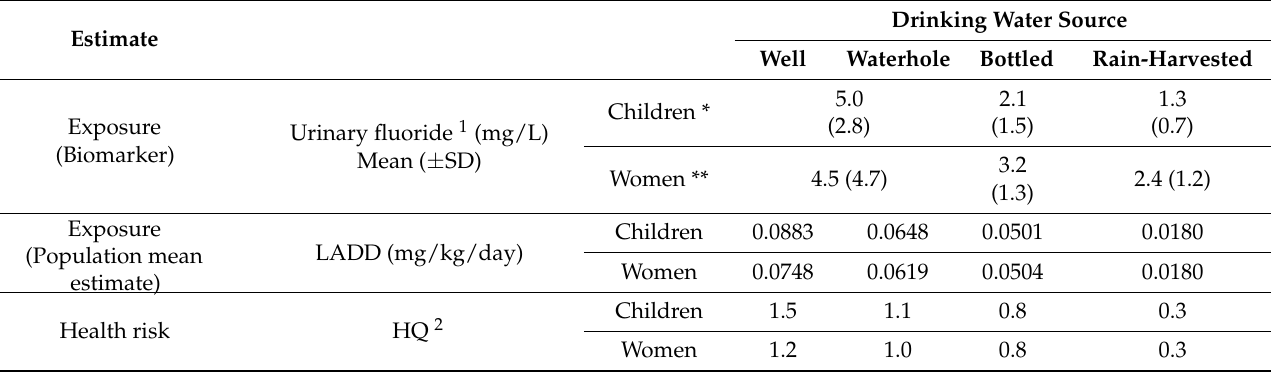
Table 3. Fluoride exposure and health risk assessed by urinary fluoride concentration, lifetime average daily dose (LADD), and hazard quotient (HQ) in 6–14-year-old children and women from the High Basin of the the Laja River.